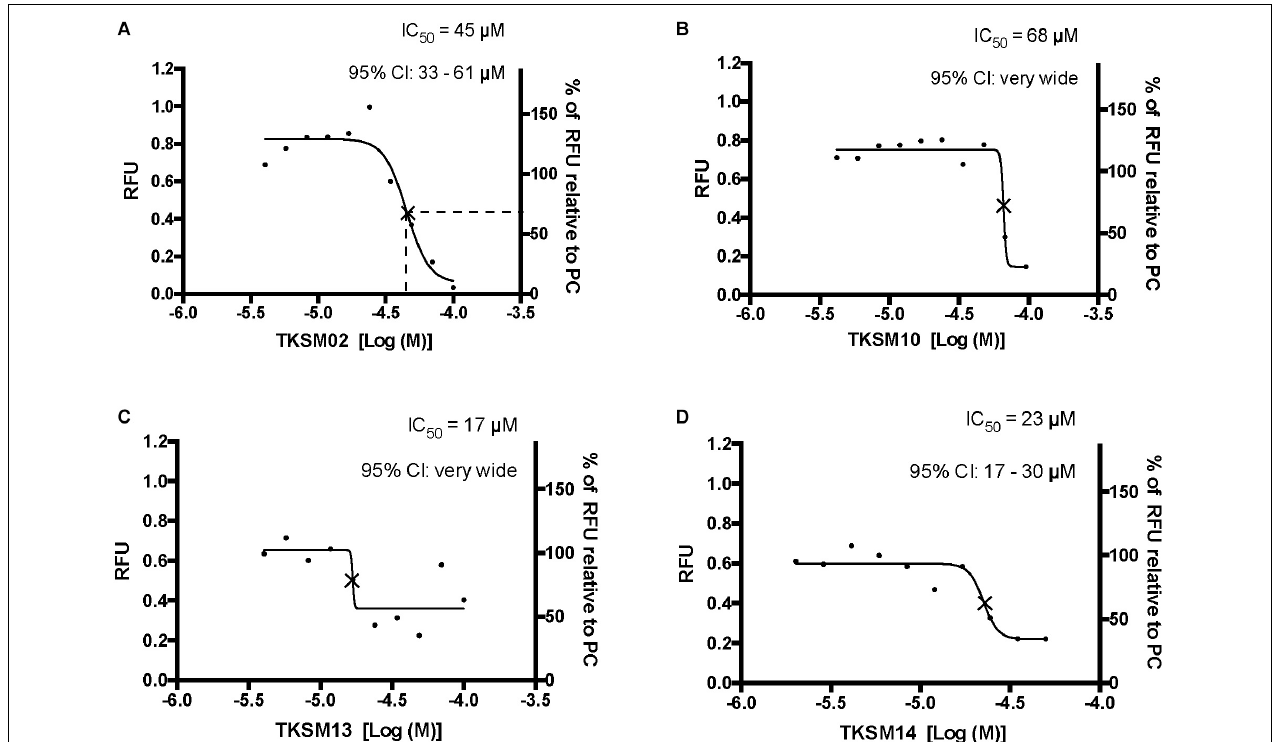
FIGURE 5 | Four small molecules antagonized the tick kinin receptor activity. Only four molecules out of the 10 tested exhibited antagonistic activities. (A–D) Dose-responses of the tick kinin receptor (in the BMLK3 cell line) to small-molecule ligands of mammalian neurokinin receptors were measured in a calcium fluorescence assay. Ten dosages were applied for each compound, starting from 100 µ M (except TKSM14, starting from 50 µ M) and following a 1:1.4 dilution series. The antagonist activity of 10 selected small molecules was tested by first dispensing the blank buffer or small molecules at various concentration [Log (Molar) on the X -axis] from the library plate into the assay plate. This was followed by incubation with the cells for 5 min, after which the kinin agonist (1 µ M FFFSWGa) of the tick kinin receptor was dispensed into all wells and incubated for another 5 min. The end-point relative fluorescence units (RFU) from each well was represented as the average RFU (left Y -axis) of two end-point reads obtained by inverting the orientation of the plate in a Varioskan LUX TM (Thermos Scientific, Waltham, MA, United States) plate reader. Additionally, the right Y -axis represents the percentage of RFU relative to the averaged responses from cells to the PC (blank buffer + agonist). Non-linear dose-response curves IC 50 s were defined as the concentration of antagonist that inhibits agonist response in the mid-range of its respective fitted dose-response curve and they are marked with a cross ( × ) on the curve. The IC 50 s and corresponding 95% confidence intervals of IC 50 S were calculated with “log(inhibitor) vs. response- Variable slope (four parameters)” in GraphPad 6.0. The IC 50 s shown here are not the concentrations that inhibit 50% of the agonist response.